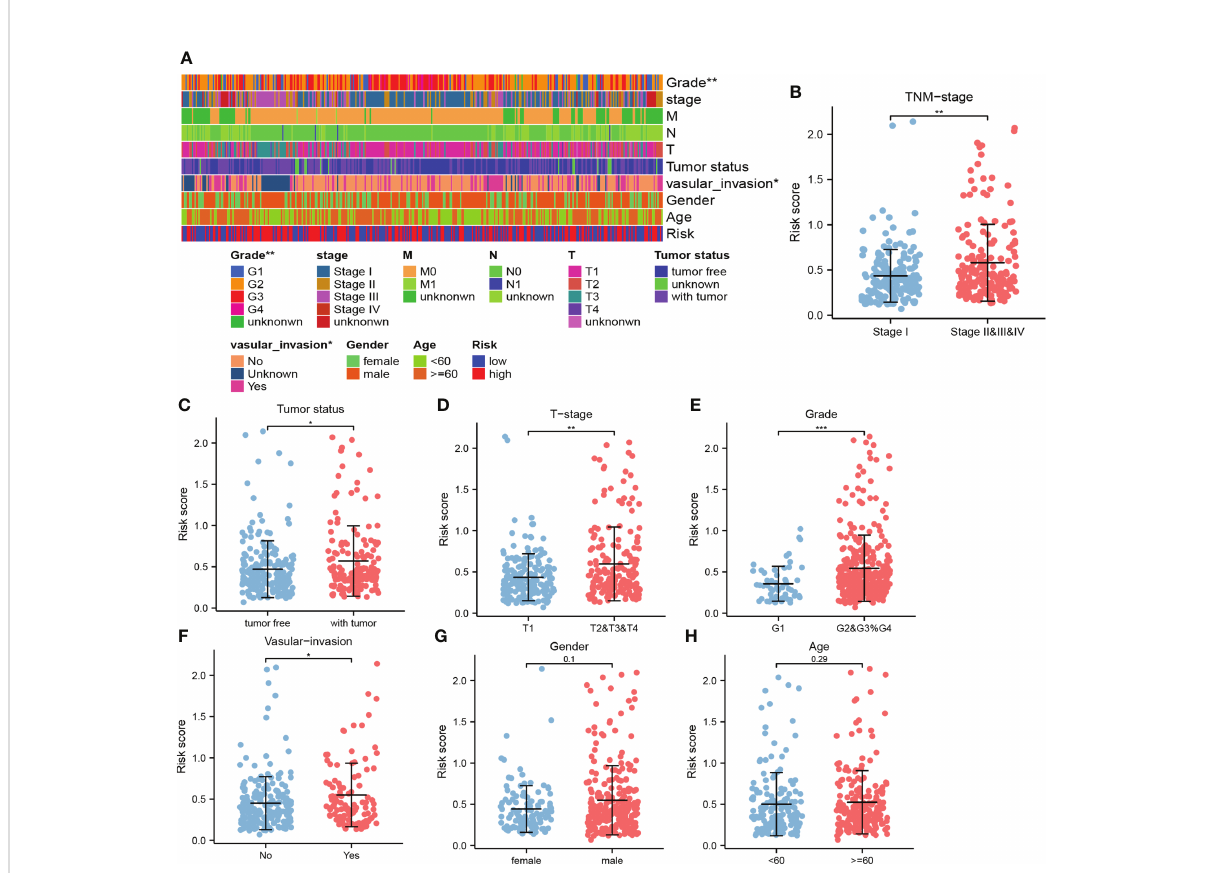
FIGURE 5 The correlation between the risk score and clinical indicators. (A) The correlation heat map. (B) Comparison of risk scores in stage I and stage II, III, and IV. (C) Comparison of risk scores in tumor- free and tumor status. (D) Comparison of risk scores in T1 and T2, 3, and 4. (E) Comparison of risk scores in G1 and G2, G3, and G4. (F) Comparison of risk scores in the presence and absence of vascular invasion. (G) Comparison of risk scores in men and women. (H) Comparison of risk scores at ages ≥ 60 vs ≤ 60 years old. (*, **, and *** represent p < 0.05, p < 0.01, and p < 0.001,